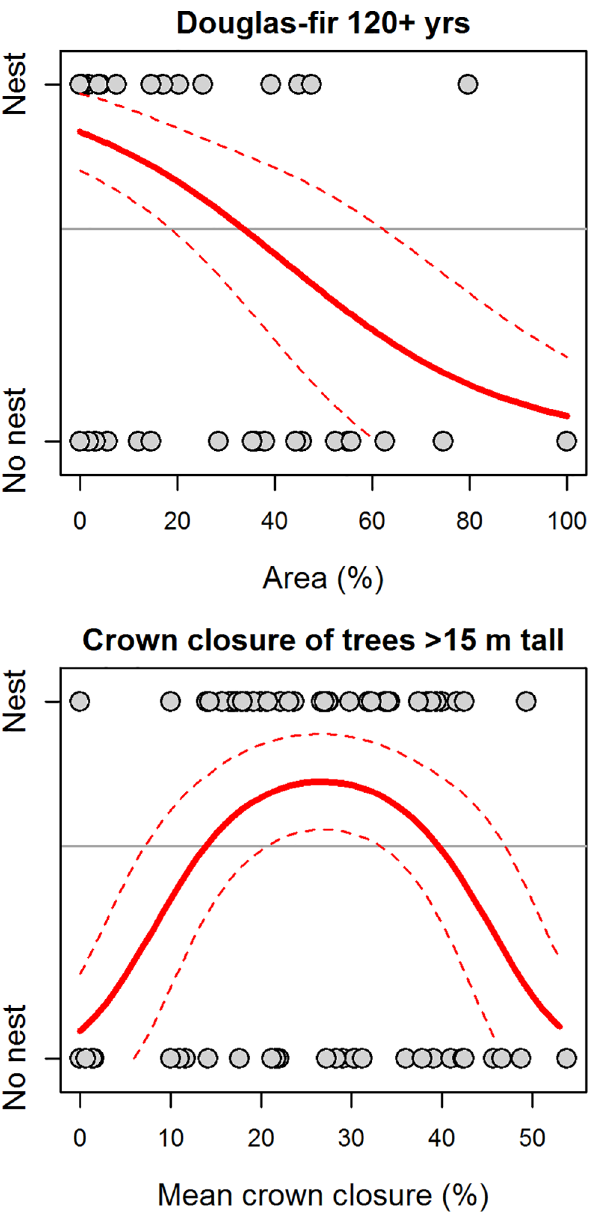
Fig 6. Predicted relationships between probability of nest occurrence and two forest habitat variables included in the GIS225 model (originally 18 variables considered) for the Western Region of the Williamson ’ s sapsucker Area of Occupancy in British Columbia, 2006 – 2008. Variables were calculated from geographic information system (GIS) data within a 225 m radius of the nest or random point. Grey points depict nest occurrence ( ‘ Nest ’ ) or a random point ( ‘ No nest ’ ), and the title of each plot indicates the habitat variable. Solid lines indicate predicted values and thin dashed lines represent the 95% prediction interval. Horizontal line depicts proportion of points that were nests (i.e., the baseline probability of response variable having a value of